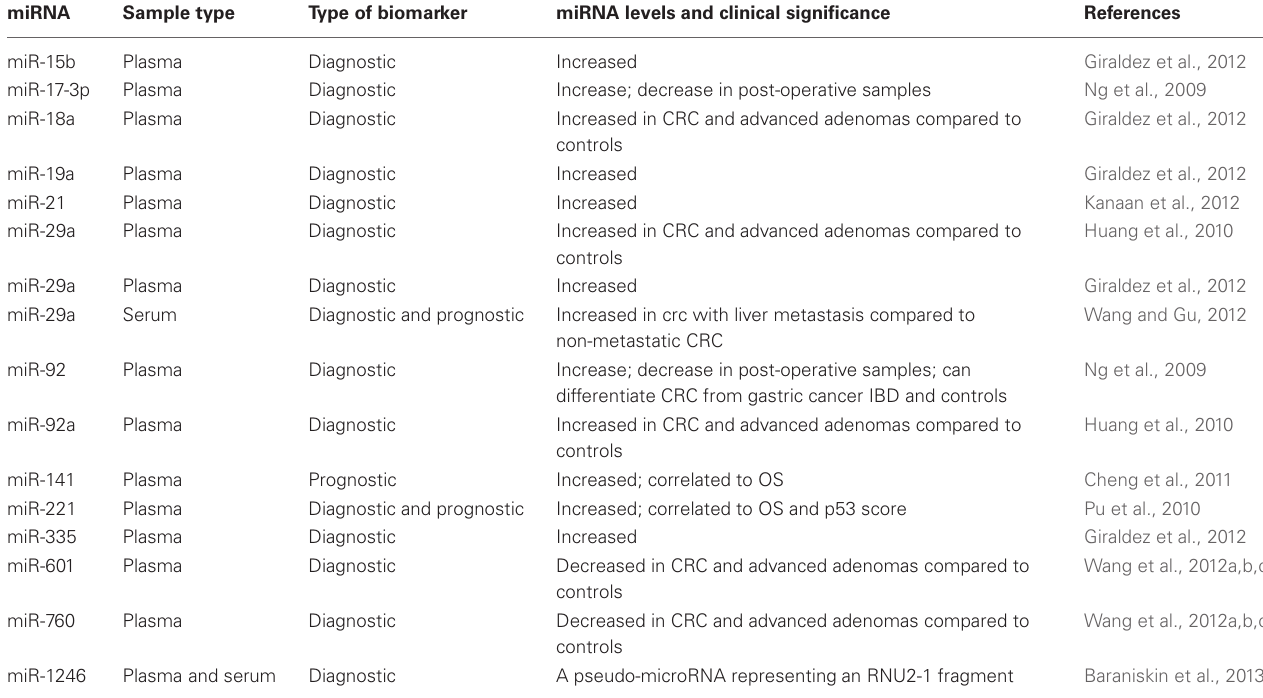
Table 4 | Circulating miRNAs reprted to be a biomarker for colorectal